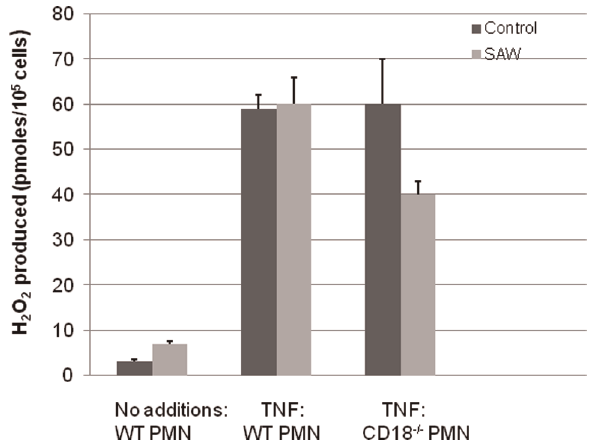
Figure 5. The effects of SAW on bone marrow derived neutrophils obtained from wild type and CD18 2 / 2 deficient mice. 10 5 Bone marrow derived neutrophils were prepared as described under Materials and Methods [30]. 10 5 neutrophils [wild type (WT) and CD18 deficient (CD18 2 / 2 )] were incubated in the absence (Control) or in the presence of 100 ng/mL of TNF a . Values reported here represent the mean 6 SEM of H 2 O 2 produced by 10 5 neutrophils incubated for 90 mins (n=3). *=p ,